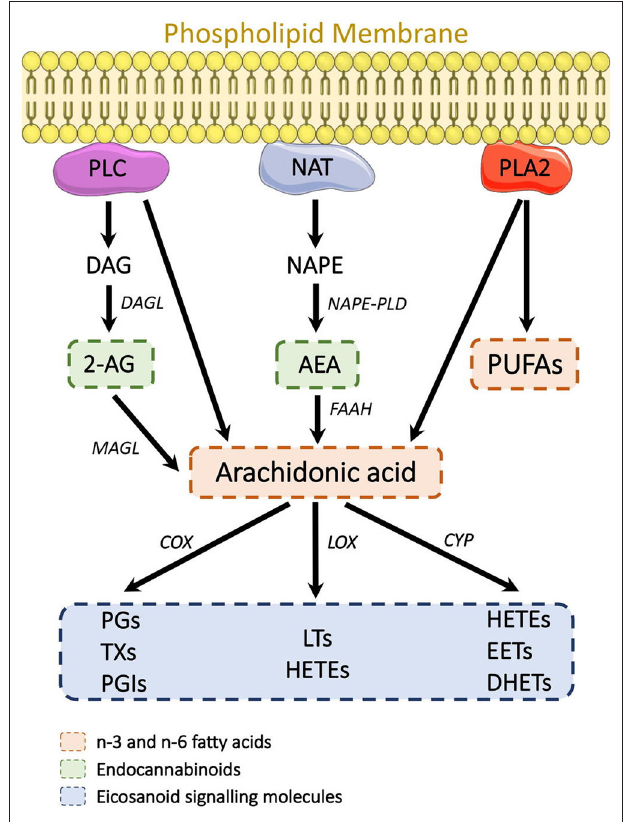
FIGURE 1 | Known lipid-derived mechanisms associated with SCZ etiology. The eCBs, FFAs, and eicosanoids all originate from the breakdown of membrane phospholipids. 2-AG is derived from PLC cleavage of PIP 2 into DAG and subsequent hydrolysis into 2-AG. NAT mediates phosphatidylethanolamine and phosphatidylcholine breakdown into NAPE, which is then converted by NAPE-PLD into AEA. PLA 2 mediates the conversion of phospholipids into FFA. AA is generated from membrane phospholipid hydrolysis by PLC and PLA 2 . AA is then further broken down in eicosanoids (PG, TX, PGI, LT, HETE, EET, and DHET) by COX, LOX, and CYP enzymes. 2-AG, 2-Arachidonoylglycerol; AA, Arachidonic acid; AEA, Anandamide; COX, cyclooxygenase; CYP, cytochrome; DAG, Diacylglycerol; DHET, dihydroxyeicosatrienoic acid; EET, eicosatrienoic acid; FFA, Free